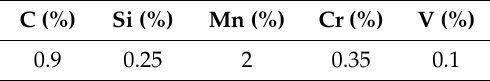
Table 2. Chemical composition of EN 90MnCrV8.